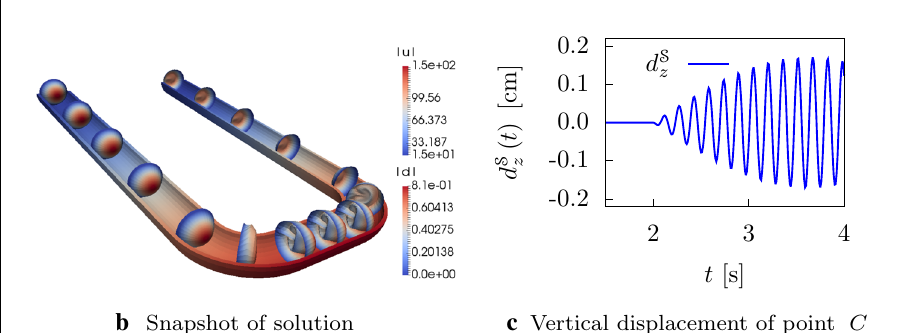
Table 5. Time integration is performed by the generalized- α method for solid dynamics [54] and fluid dynamics [55] with spectral radii ρ S ∞ = 0 . 8 and ρ F ∞ = 0 . 5, respectively. The time step size is chosen as (cid:7) t = 0 . 005 s for the results presented below. The solid field is selected as master field, i.e. the interface motion is described in terms of solid